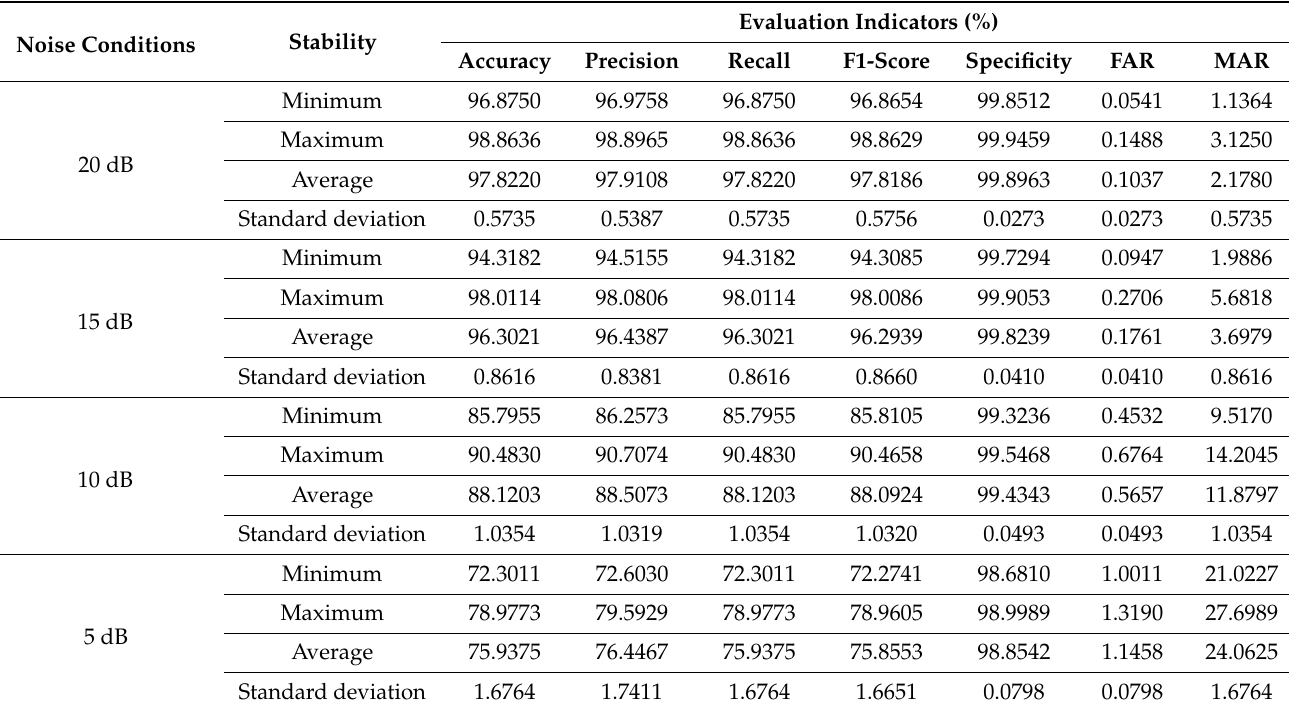
Table 5. The diagnostic results of the proposed method for all noise